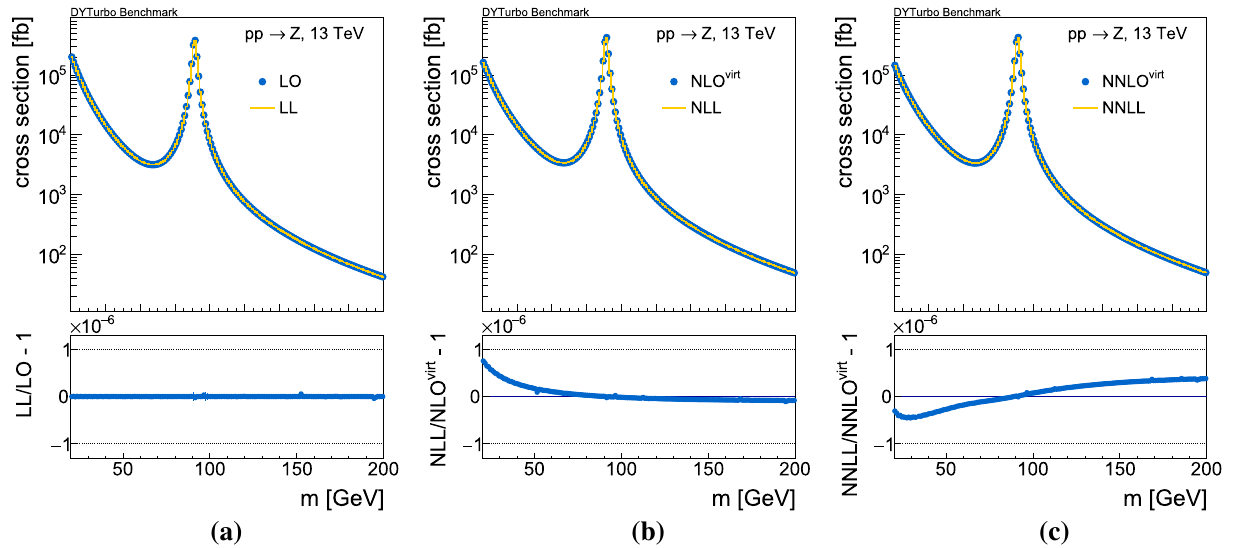
(cid:7) ∞ d q 2 d σ res = H V × d ˆ σ V for (NNLO virt ) identify the contribution of the regularised virtual correc- √ T LO 0 s = 13 TeV, results at: a LO and LL, tions up to one-loop (two-loop) order